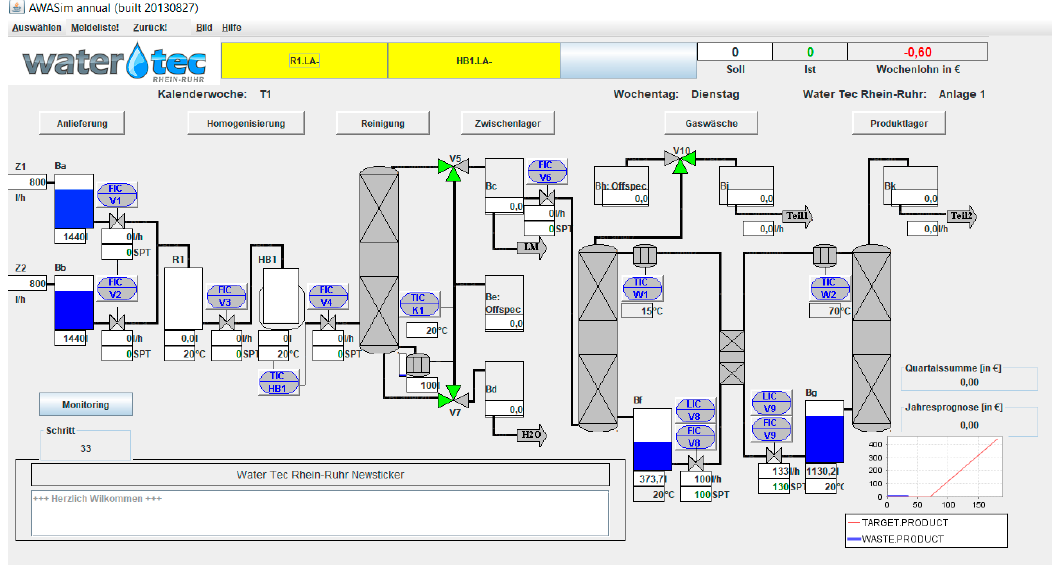
Figure 1. AWAsim Interface with valves, tanks and heaters. On the right: (top) numerical salary display, (bottom) graphical production/safety display.